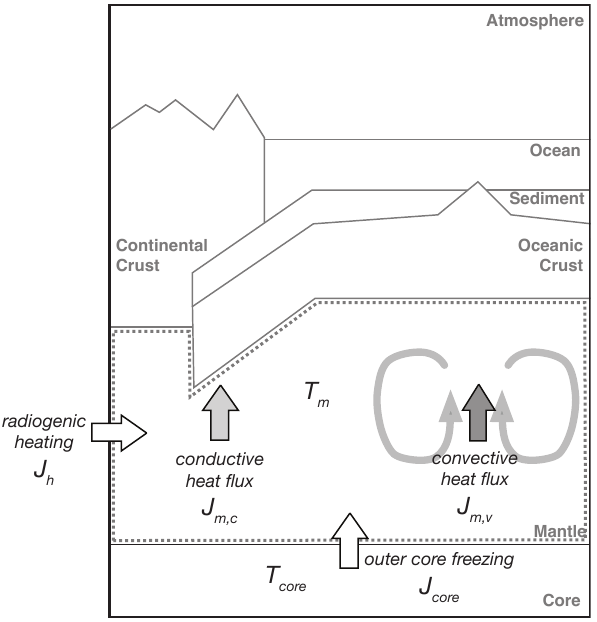
Fig. 4. Mantle convection: The mantle is heated via decay of ra- diogenic elements, J h and release of heat from outer core freezing, J core . This heat along with fossil heat flows to the surface via con- duction, J mc , and convection, J mv . The temperature of the mantle and core are denoted with T m and T core respectively.